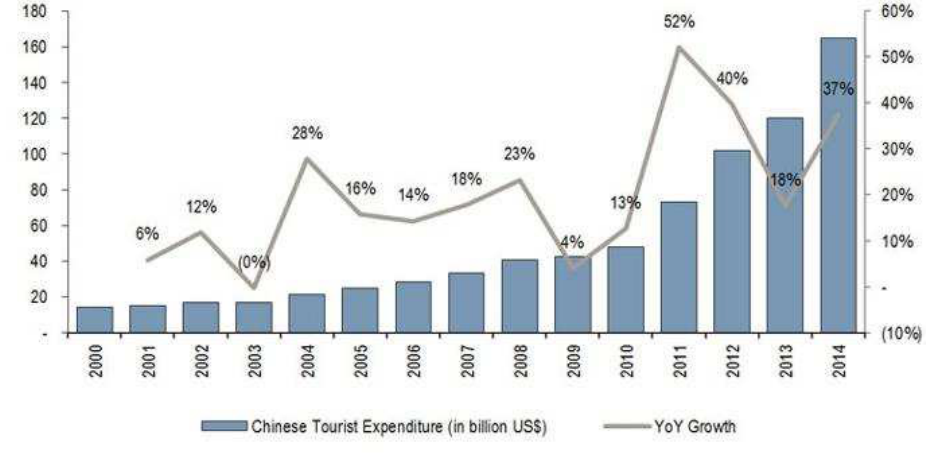
Source: Credit Suisse,